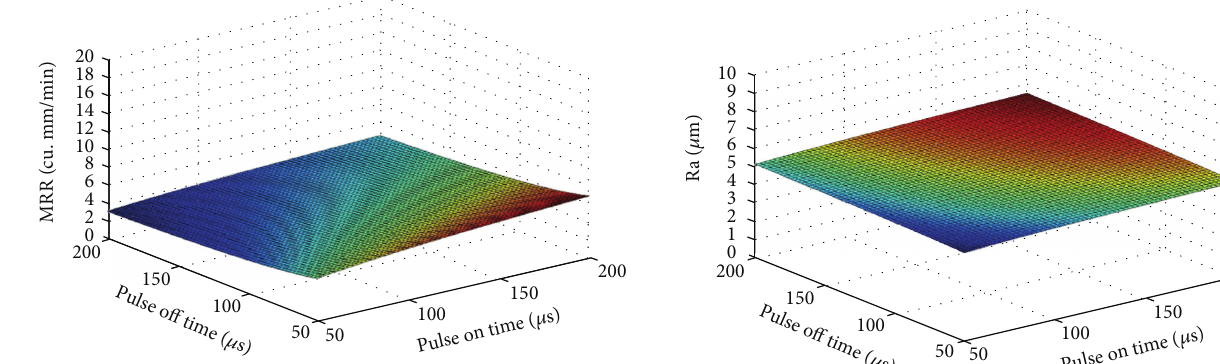
Figure 4: Effect of current and pulse on time on surface roughness (Ra) at pulse off time = 125 𝜇 s.